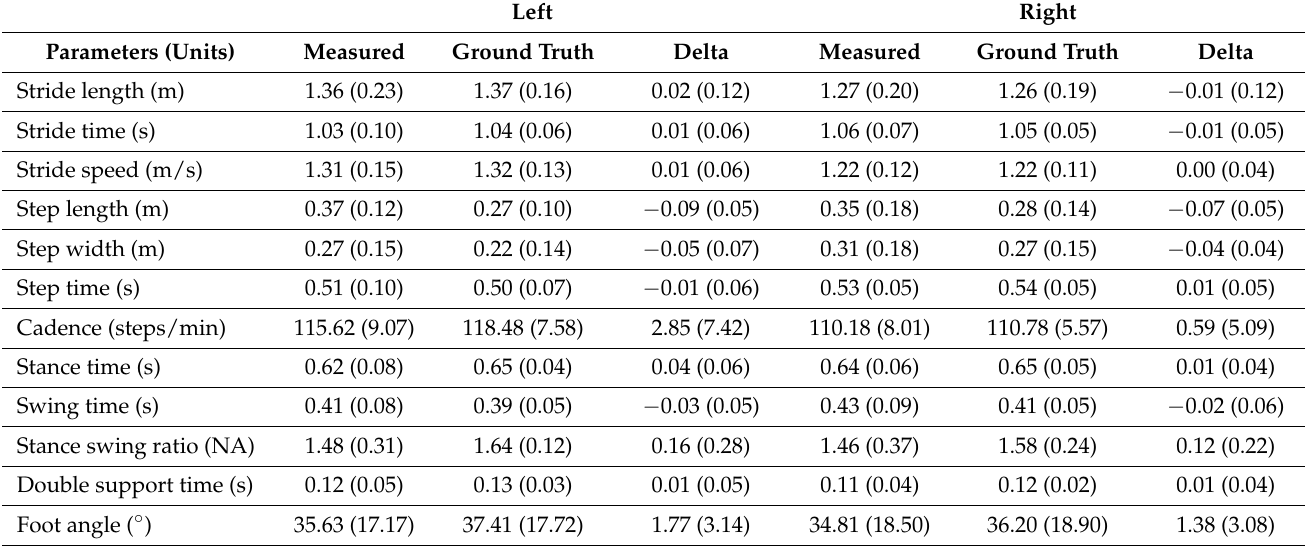
Table A9. Stride parameters for participant two: walking-curve test (mean and standard deviation in brackets). Left Right